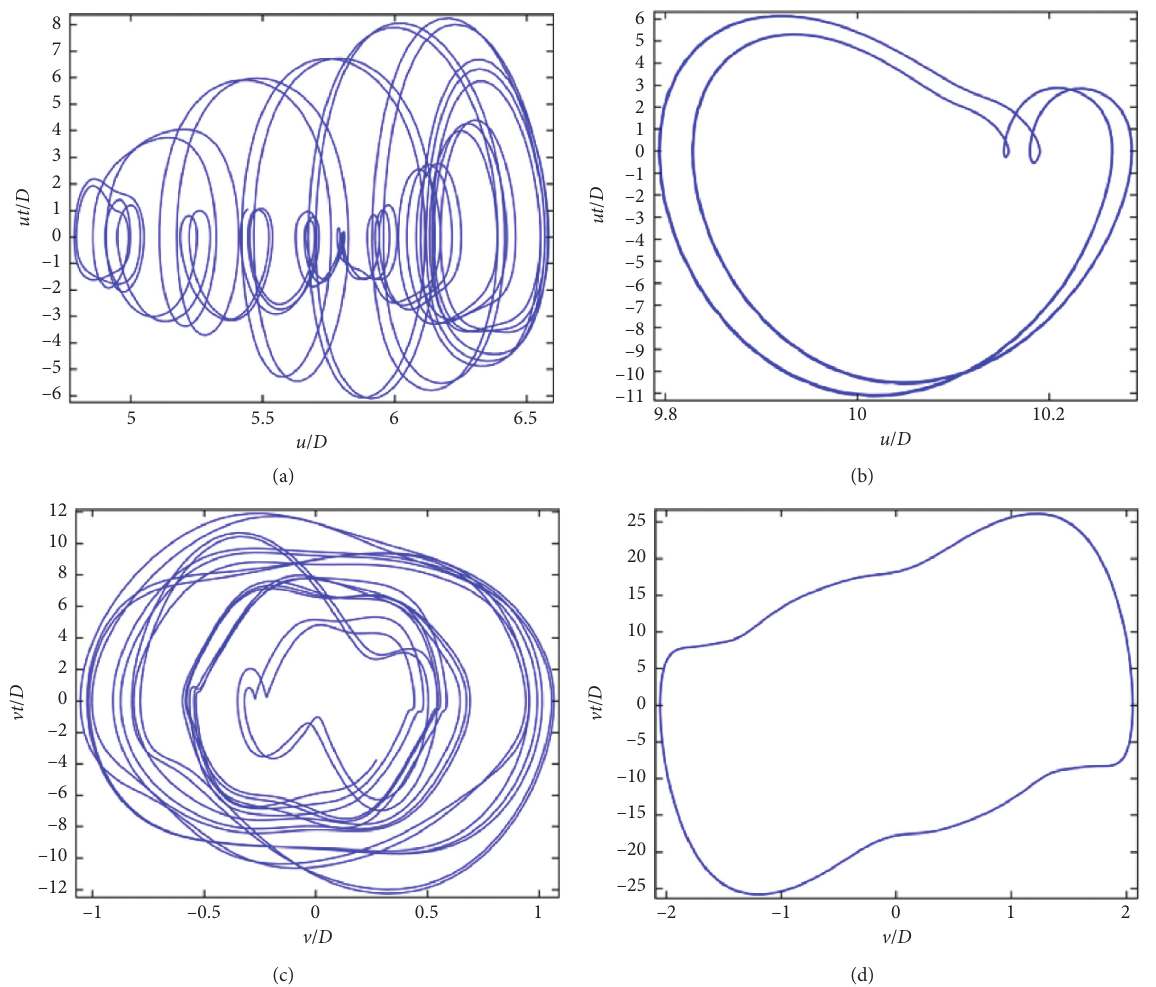
Figure 13: The phase diagram of the marine riser considering the coupling effect: the phase diagram of the in-line with (a) A / D � 1.2 and (b) A / D � 3.0 and the phase diagram of the cross-flow with (c) A / D � 1.2 and (d) A / D �